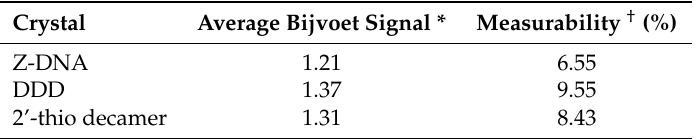
Figure 10. Scatter plot of correlation coefficient for all data, CCall, and related Patterson Figure of Merit, PatFOM, values over 10,000 tries for SHELXD with Z-DNA data. Tries resulting in useful phases are red and unsuccessful tries are green. Table 5. Measurability of Bijvoet